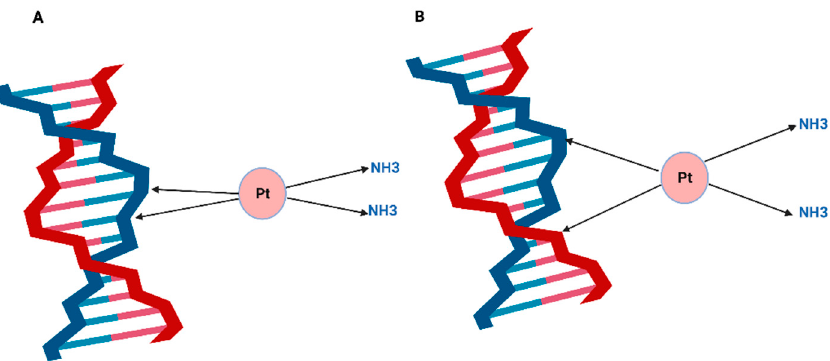
Figure 2. Cisplatin DNA adducts are formed when cisplatin exchange one or two of its chloride molecules for water and bind covalently to the purines at the N7 position to form ( A ) Cisplatin intra-strand adduct or ( B ) Cisplatin inter-strand crosslink. Illustrations created by BioRender.com (accessed on 8 May 2022).